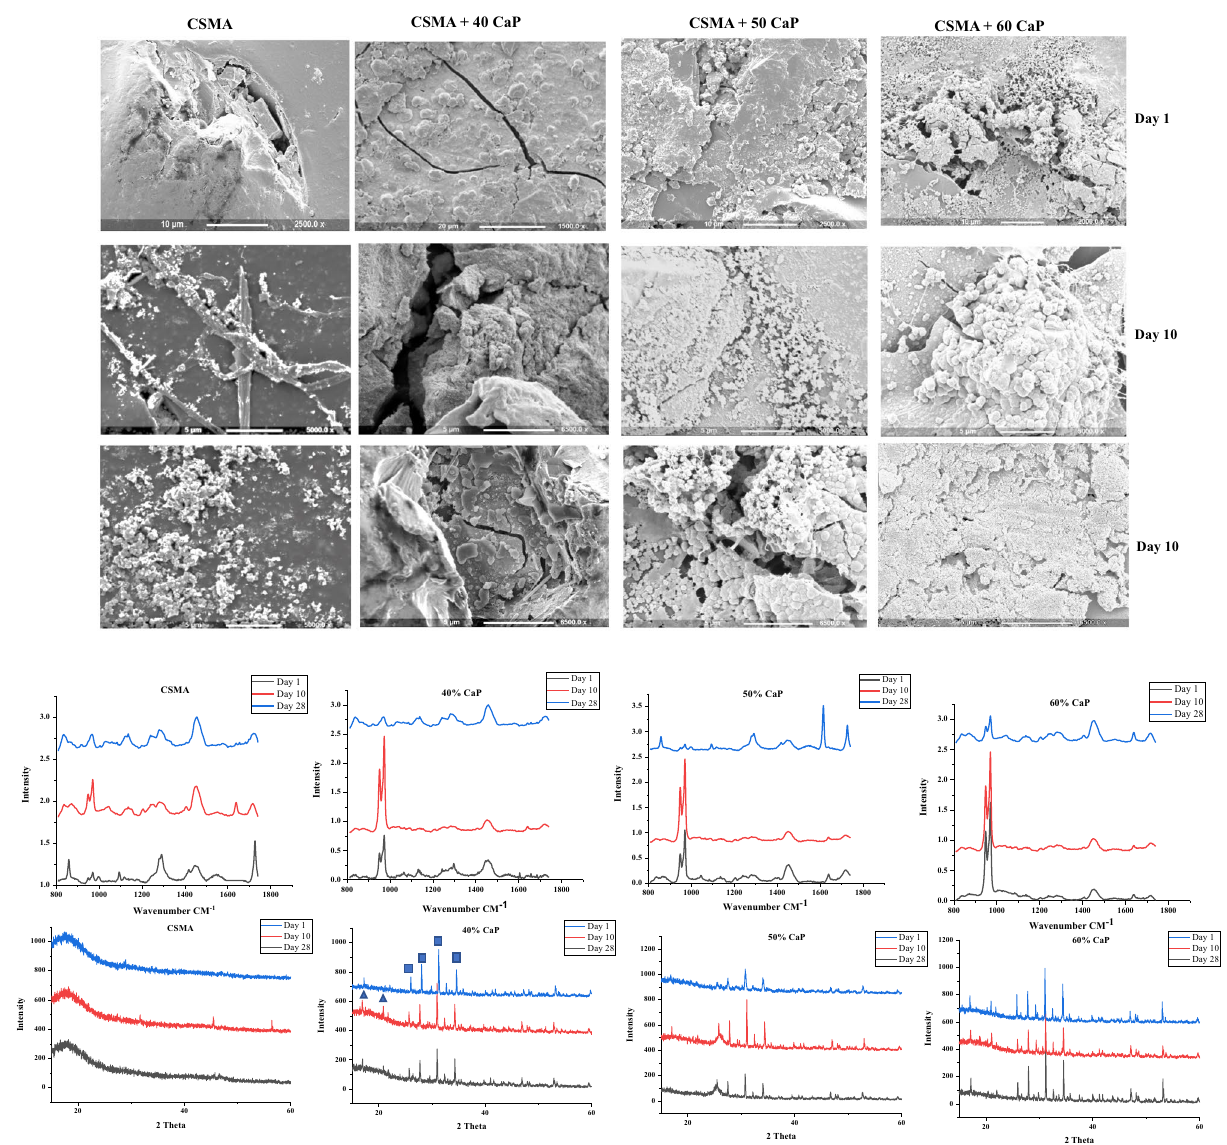
Figure 4. SEM present a series of images of CaP deposition on the surface of the composite discs compared to CSMA. 60% CaP formulation displays the highest quantity of precipitants on the surface, followed by 50 and 40% formulations respectively. Raman microscopy on the first bottom row shows the highest peak at 50% formulation followed by 60 and 40. Subsequently, the presence of CaP precipitates observed via SEM microscopy was confirmed through XRD analysis 1, 10, and 28-days post SBF immersion and